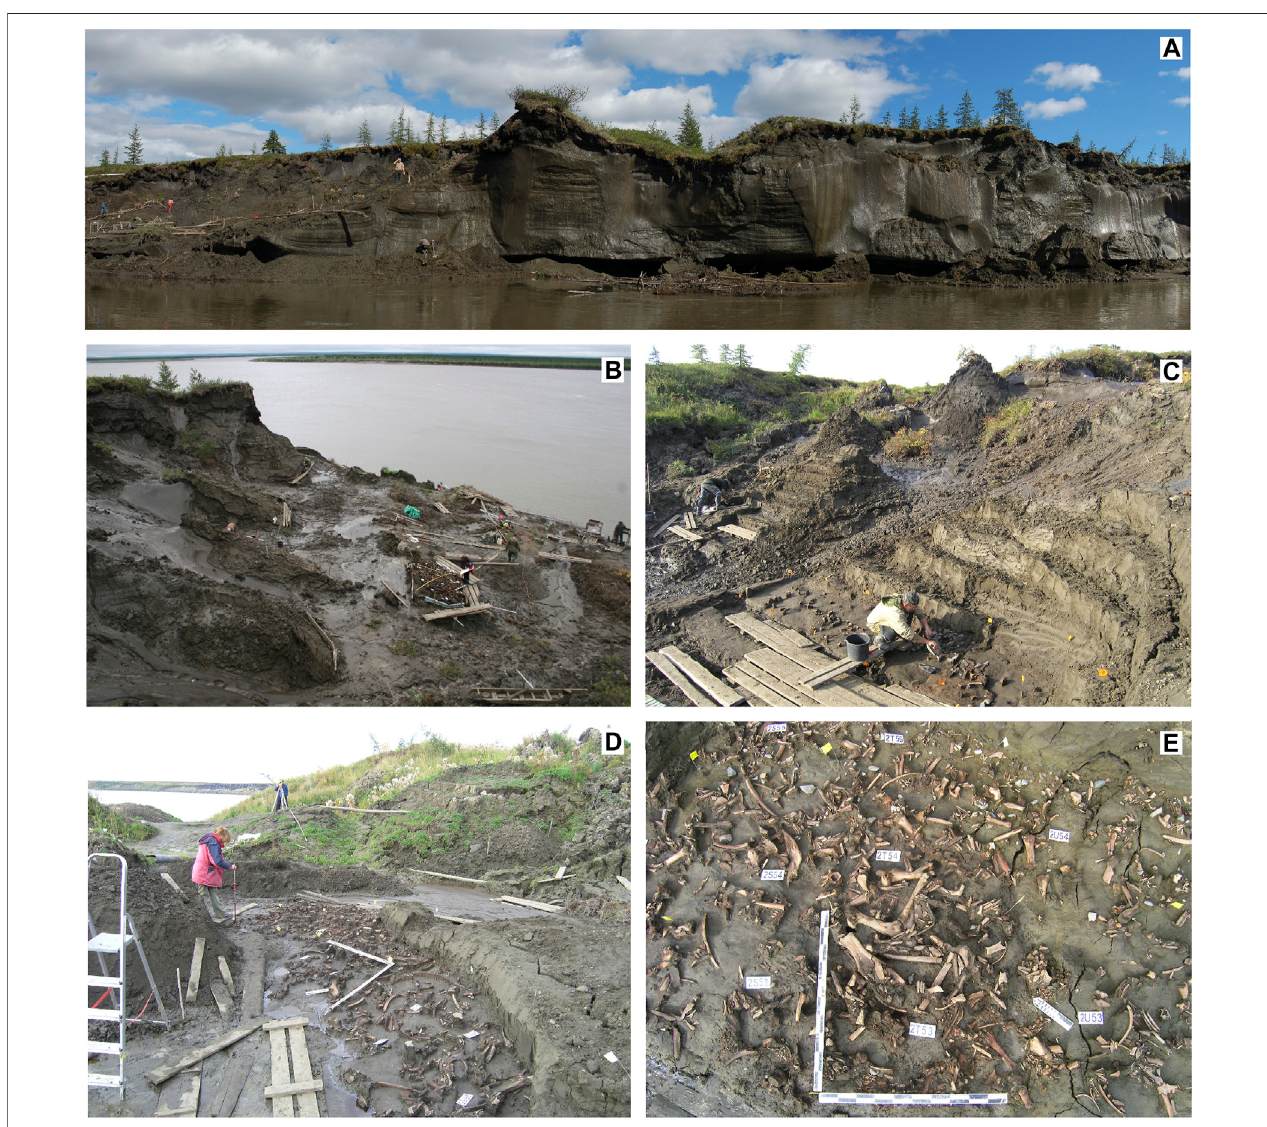
FIGURE 2 | The Northern Point area (NP) of the Yana site complex: (A) panoramic view on the exposure of the Ice Complex deposits with the area excavated in 2008; (B) – theNorthernPointexcavationareaviewedfromtheNorth-Westin2007withclearlyvisiblepermafrostpolygonalpatternsincludingareascoveredbyculture- bearingdepositsisolatedinsidethepolygonswalled bytheice-wedgenetwork; (C) – excavationsoftheculturallayerinneighboringpolygonsin2009; (D) – recordingof the excavated material during 2012 excavation campaign; (E) – example of the excavated area of the cultural layer bearing dense accumulation of archaeological fi nds – lithic and bone artifacts, and Pleistocene animal